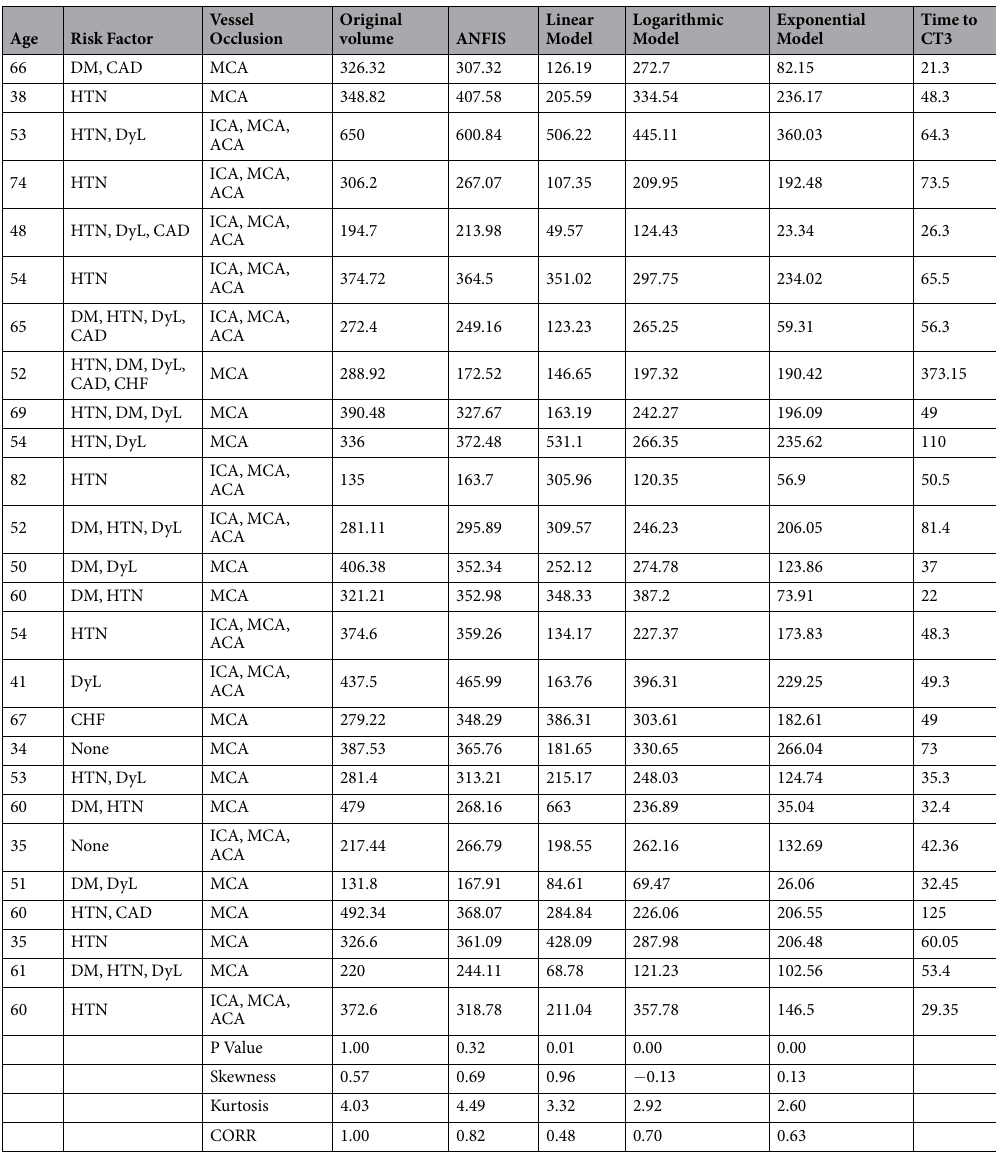
Table 2. Individual patient data of third infarct volume, original and predicted by various methods at time of CT3, CORR Cross correlation, and high order variability of predicted values by various methods used for IV3 prediction. Infarct volume is in cm 3 , Time CT3 in hours. DM-diabetes mellitus, HTN-hypertension, DyL- dyslipidemia, CAD-coronary artery disease, CHF-congestive heart failure, ICA-internal carotid artery, MCA- middle cerebral artery, ACA-anterior cerebral